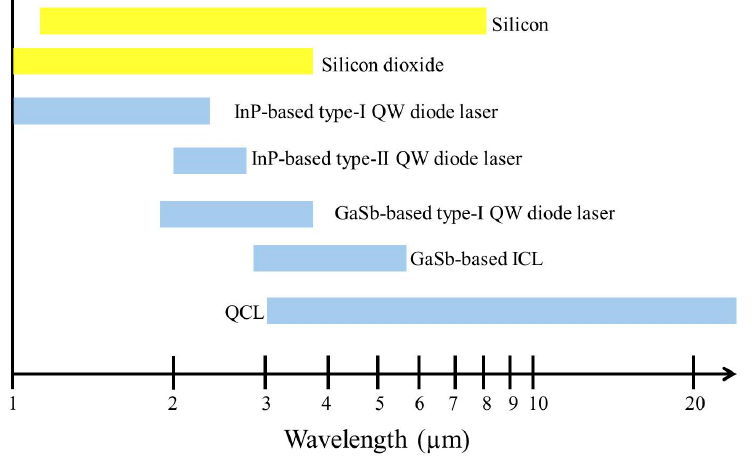
Figure 2. Transparent window of silicon and silicon dioxide, and emission wavelength coverage of semiconductor lasers based on different III–V active regions. InP-based type-I, type-II and GaSb-based type-I quantum well (QW) diode lasers, GaSb-based interband cascade lasers (ICLs), and QCLs are included.